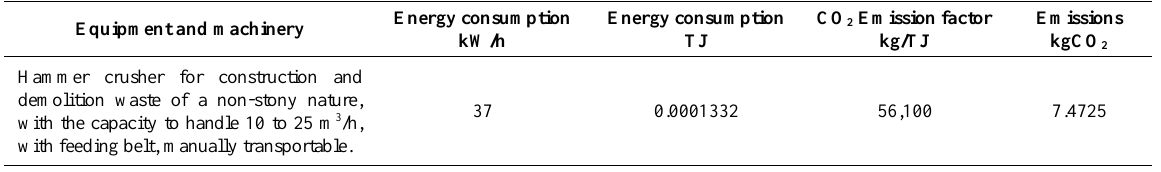
Table 7. Analysis of CO 2 emissions of equipment and machinery (waste crusher).